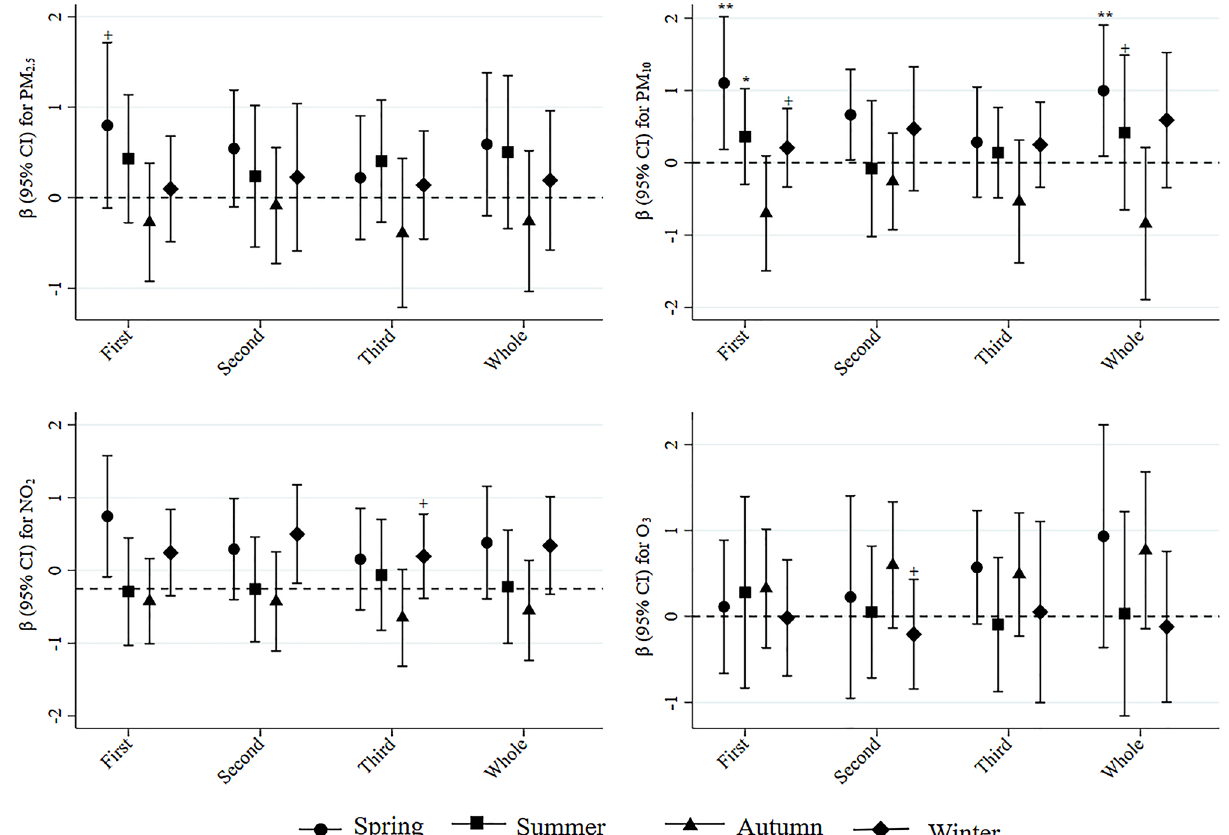
Figure 2. Adjusted differences in PSS scores per IQR increase in air pollutants stratified by season. Analyses were adjusted for maternal age, education, smoking, occupation, drinking during pregnancy, parity, pre- pregnancy BMI, gestational age, income, asthma, thyroid disease, malignant tumors, liver diseases, and hypertension or diabetes. + p for interaction < 0.1. *p for interaction < 0.05. **p for interaction < 0.01.